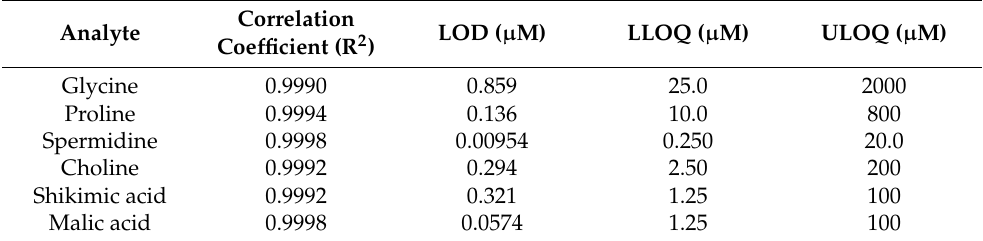
Table 2. Calibration Regression, LOD, LLOQ and ULOQ of Representative Analytes.